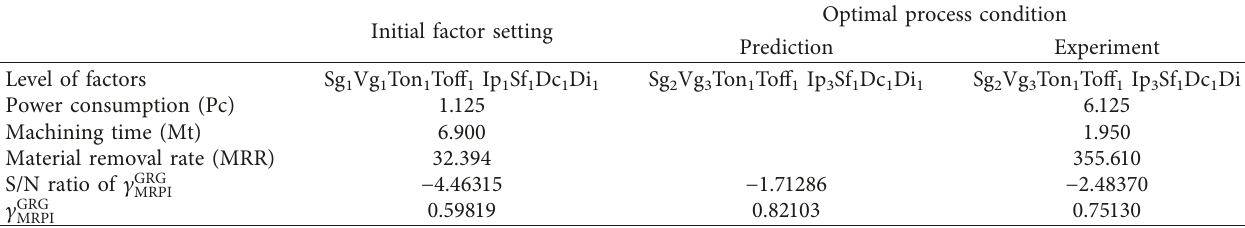
Table 20: Results of confirmatory experiment for overall grey relational grade (OGRG).